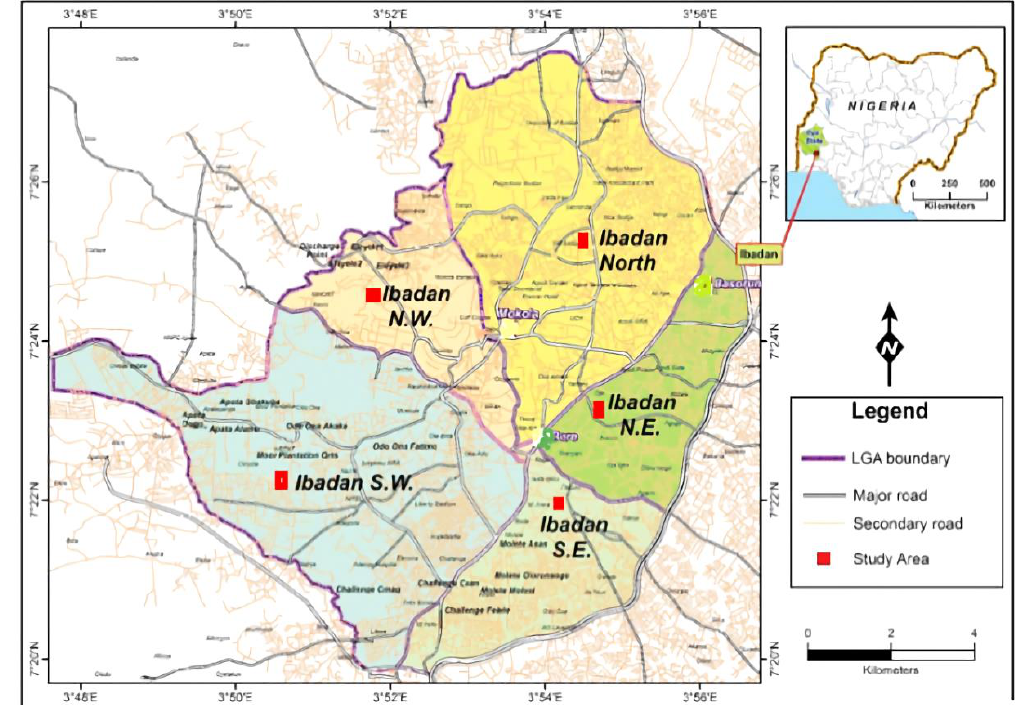
Figure 1. Map of Ibadan Metropolis